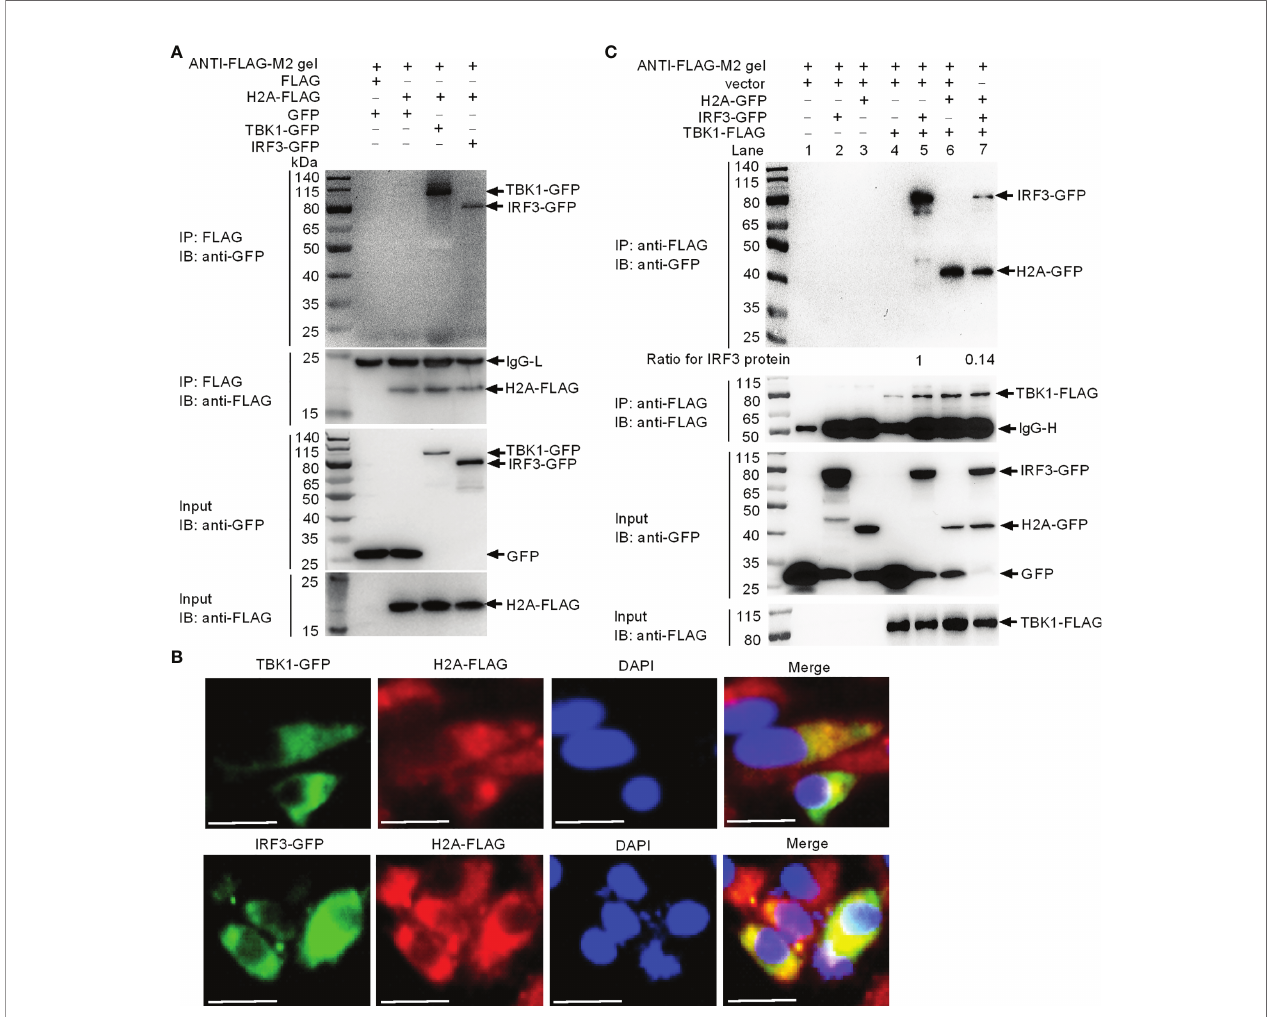
FIGURE 3 | Zebra fi sh histone H2A interacts with TBK1 and IRF3 to disrupt the formation of TBK1-IRF3 complex. (A) Zebra fi sh histone H2A interacted with TBK1 and IRF3. (B) Zebra fi sh histone H2A colocalized with TBK1 and IRF3. (C) Zebra fi sh histone H2A interacted with TBK1 to inhibit the formation of TBK1-IRF3 complex. For (A, C) , co-IP was performed with anti-FLAG-conjugated agarose beads in EPC cells. The cell lysates and bound proteins were analyzed by immunoblotting with the indicated Abs. All experiments were repeated for at least three times with similar results. The expression ratio for IRF3 protein was quanti fi ed by Quantity One. For (B) , immuno fl uorescence analysis was performed in EPC cells transfected with H2A-FLAG and TBK1-GFP or IRF3-GFP. Scale bar: 25 m